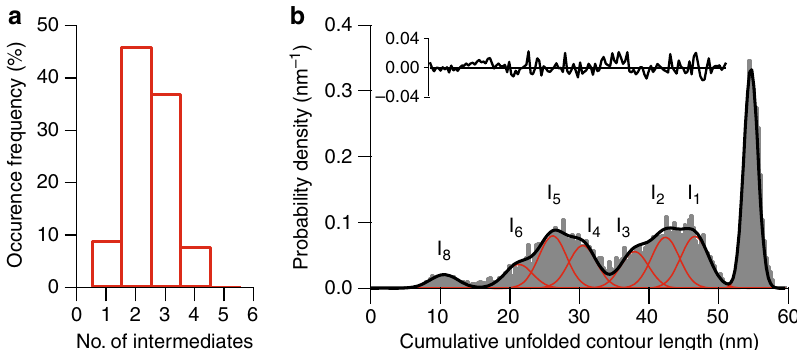
Fig. 2 Refolding intermediates. a The distribution of the number of intermediate states observed in refolding FECs. b The distribution of the cumulative contour length of unfolded protein at each state observed in the refolding FECs, as measured from the natively folded state via WLC fi ts. The positions of seven intermediate states were identi fi ed by Gaussian fi ts (red) of the peaks in the distribution, all but one matching intermediates seen during unfolding